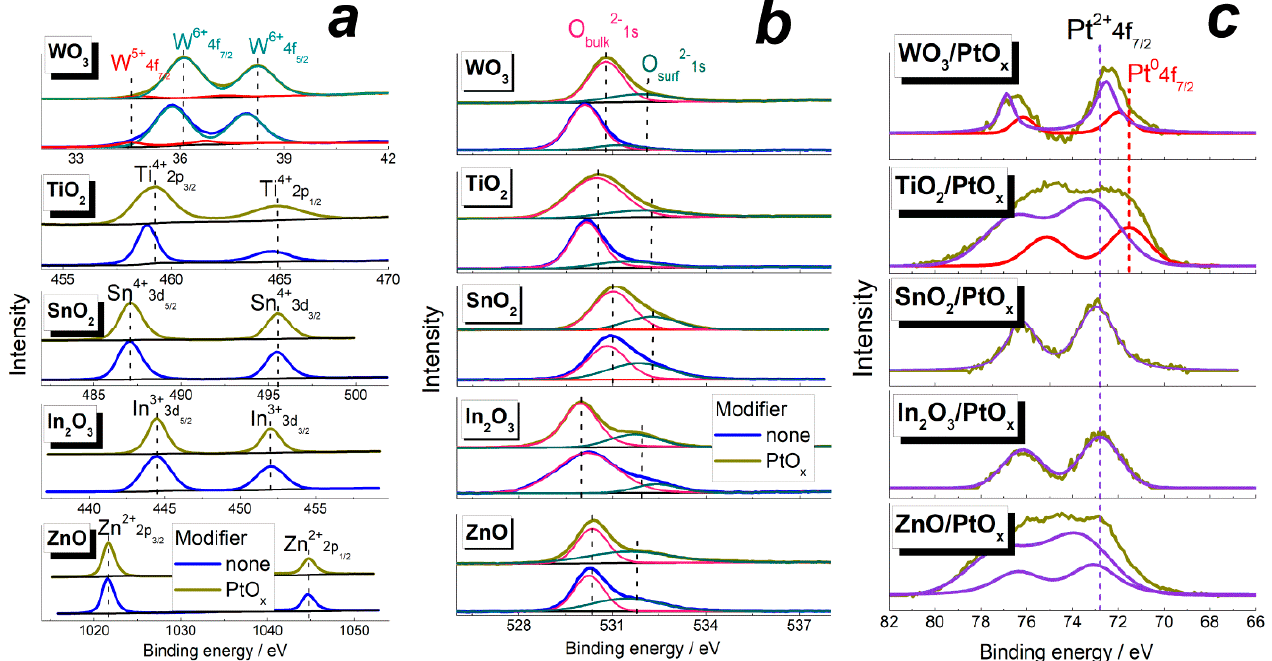
Figure 2. High-resolution XP-spectra of MOS and MOS/PtO x materials in the characteristic binding energy limits of metals constituting MOS ( a ), O 1s ( b ), and Pt 4f ( c